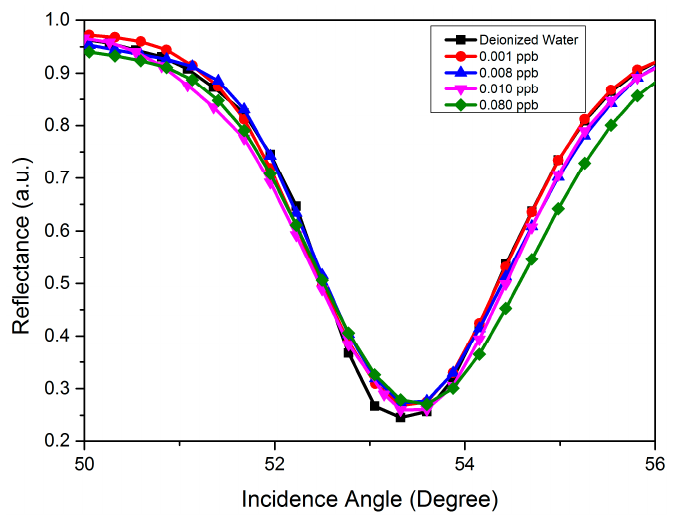
Figure 13. SPR reflectance curve as a function of incidence angle for gold thin film in the detection of different concentrations of carbaryl.